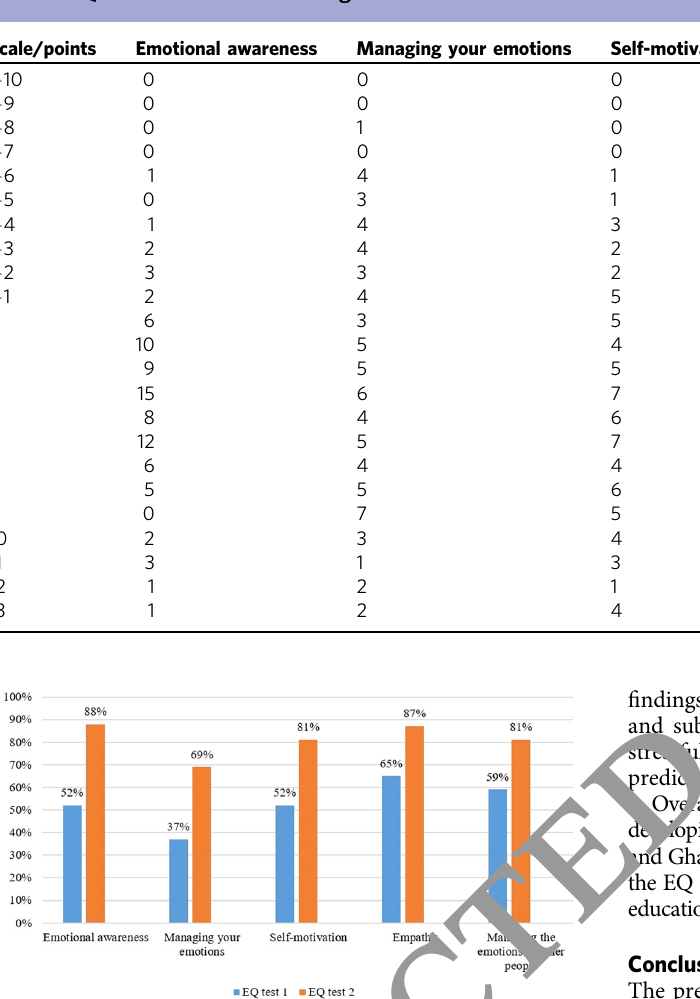
Table 2 EQ test results after training.